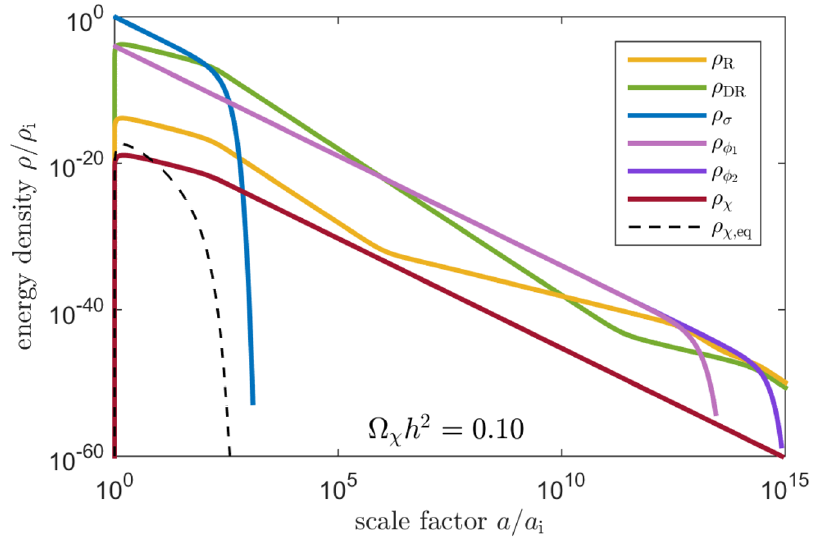
Figure 8 . Energy density evolution of the various components as functions of scale factor in the two-moduli scenario for the benchmark point in table 2.